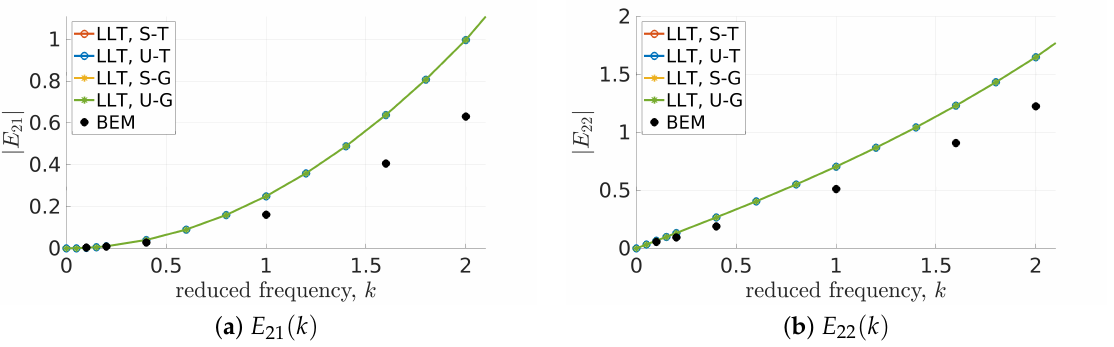
Figure 12. Magnitude of transfer functions E 21 ( k ) and E 22 ( k ) , NMV shape functions, l =